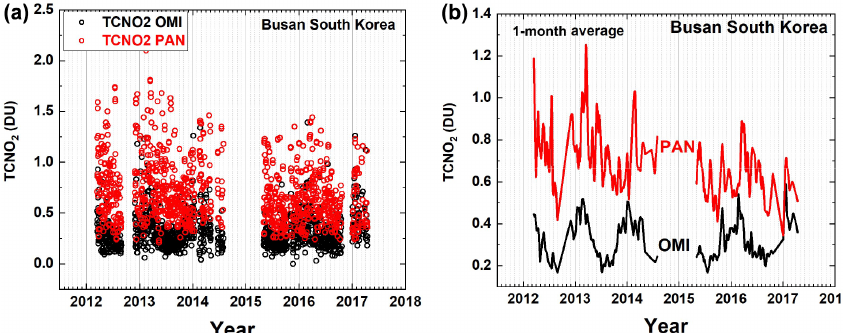
Figure 3. Extended time series for Busan. (a) Individual matching PANDORA and OMI data points for the overpass time ± 6min. (b) Monthly